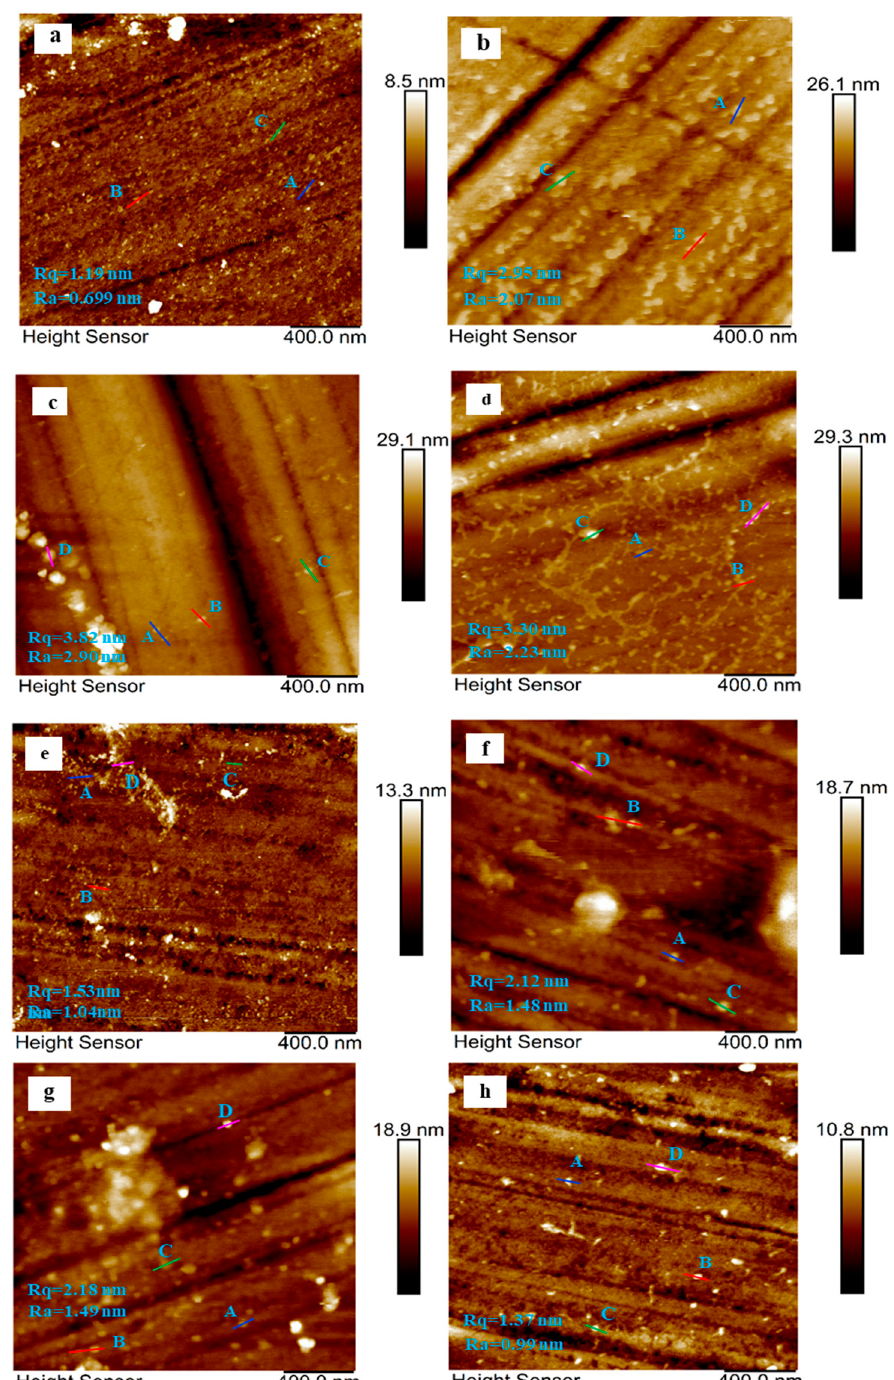
Figure 12. Two-dimensional AFM images of adsorbed fatty acid on rhodochrosite. ( a ) 1 × 10 − 6 mol / L SA, ( b ) 1 × 10 − 4 mol / L SA; ( c,e,g ) 1 × 10 − 5 mol / L OA, LA, ALA respectively; ( d , f , h ) 1 × 10 − 3 mol / L OA, LA, ALA respectively. The blue, red, green and carmine lines represent the transverse section position of adsorbed fatty acid.